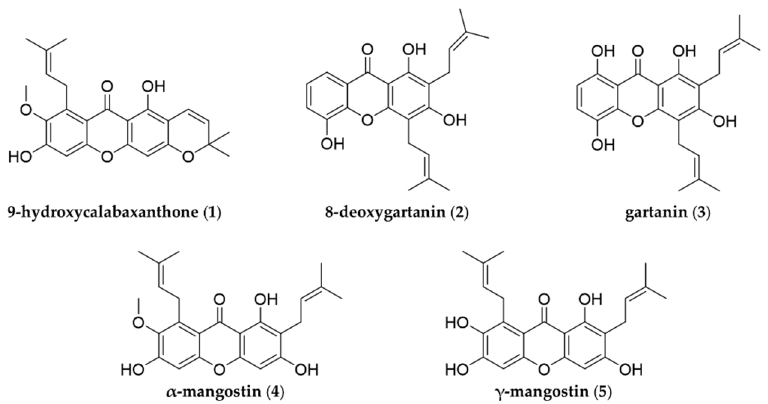
Figure 1. Isolated compounds ( 1 – 5 ) from the pericarp of G. mangostana